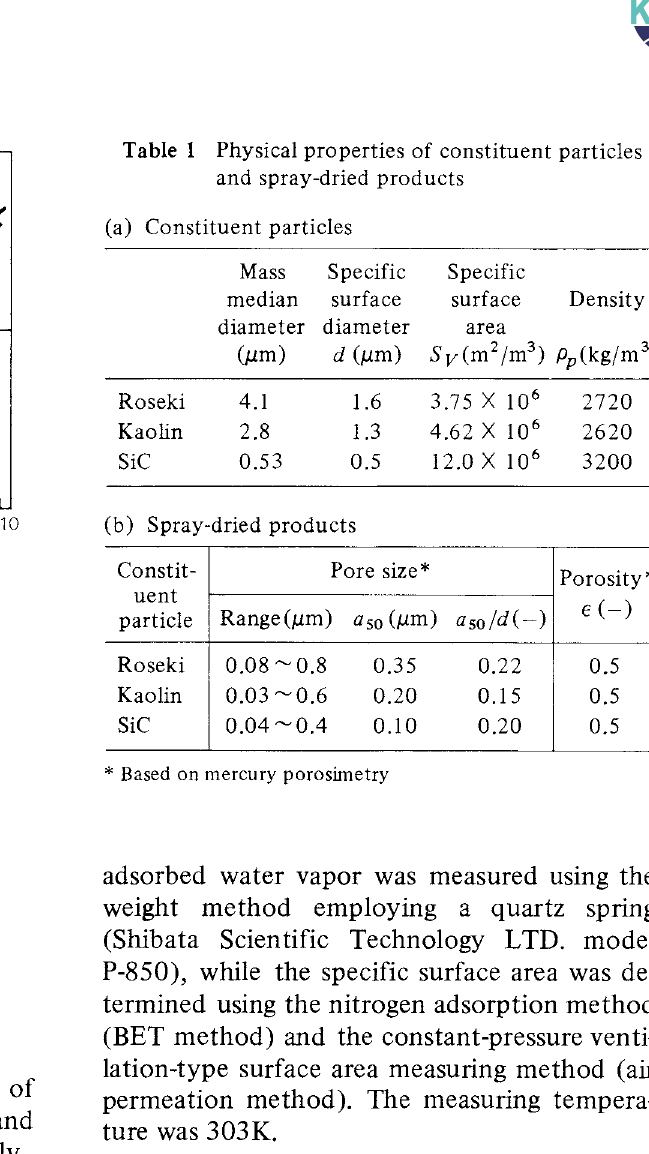
Fig. 1 Size distribution of constituent particles